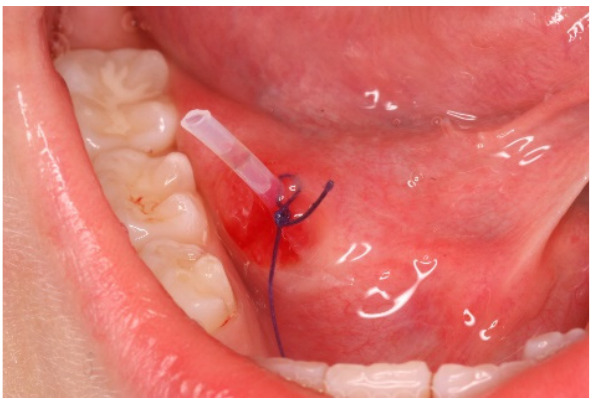
Figure 3. This figure shows the marsupialization technique (attempt n° 1): rubber drainage tube inserted into the lesion after bubble dome removal and sutured to avoid ostium closure.